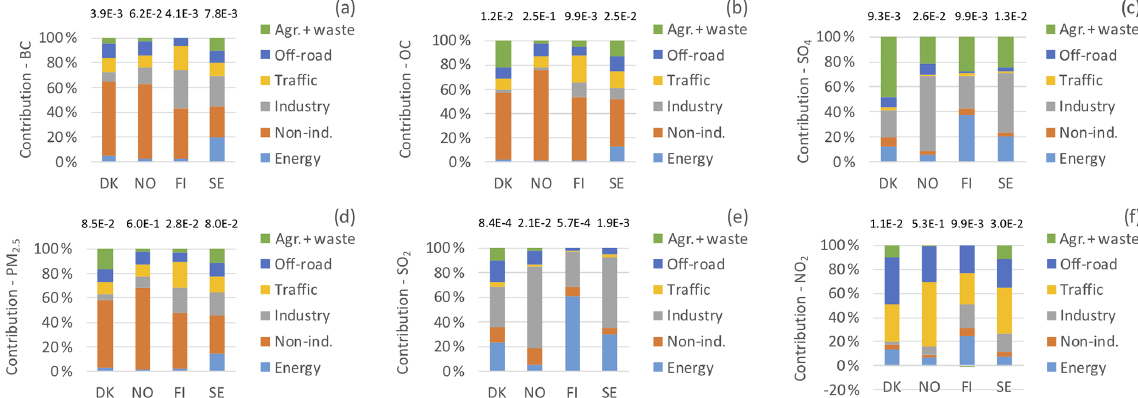
Figure 7. Population-weighted sectoral contributions of Norwegian emissions on surface (a) BC, (b) OC, (c) SO 4 , (d) PM 2 . 5 , (e) SO 2 and (f) NO 2 over the Nordic countries. The labels above the bars show the absolute total contribution in µgm − 3 from all the sectors in Norway.